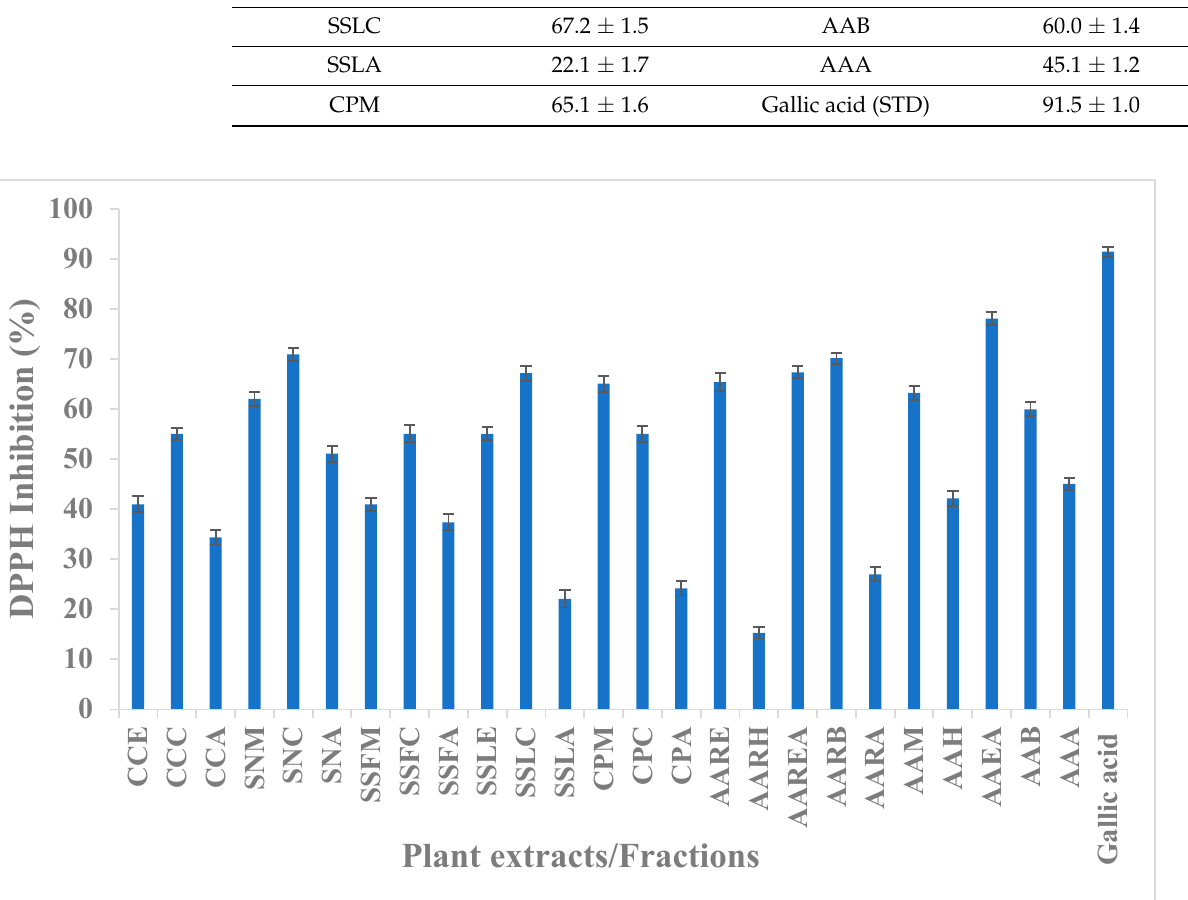
Figure 4. Graph of antioxidant activity of plant extracts.